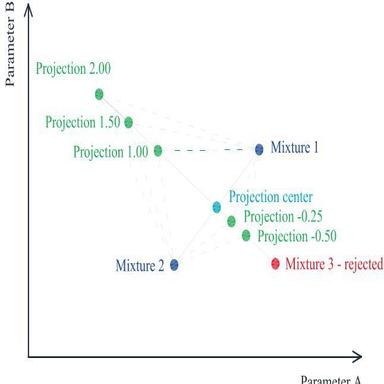
A schematic illustration of the simplex optimization step.